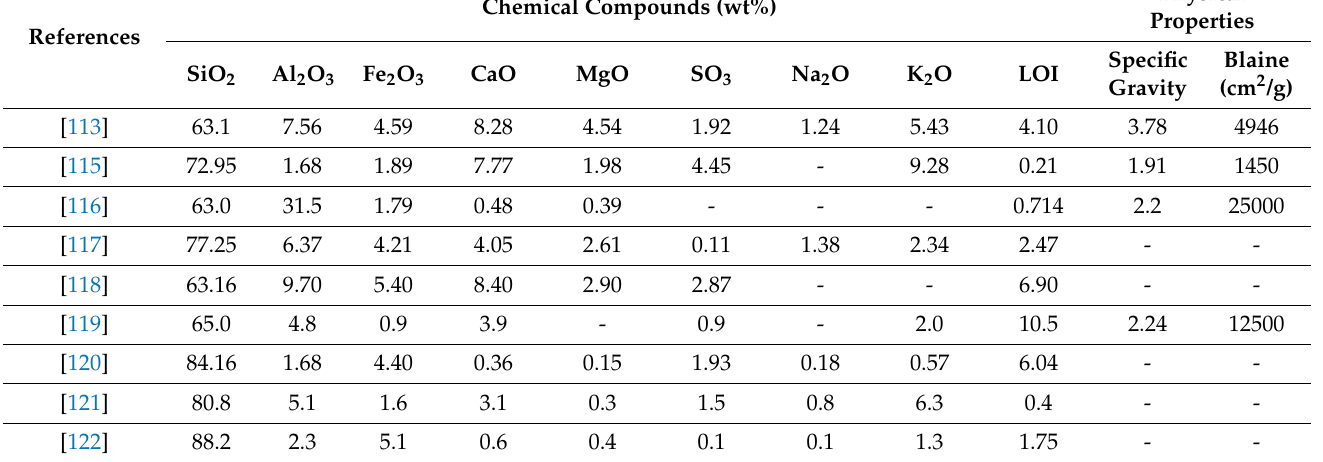
Table 5. Chemical composition of